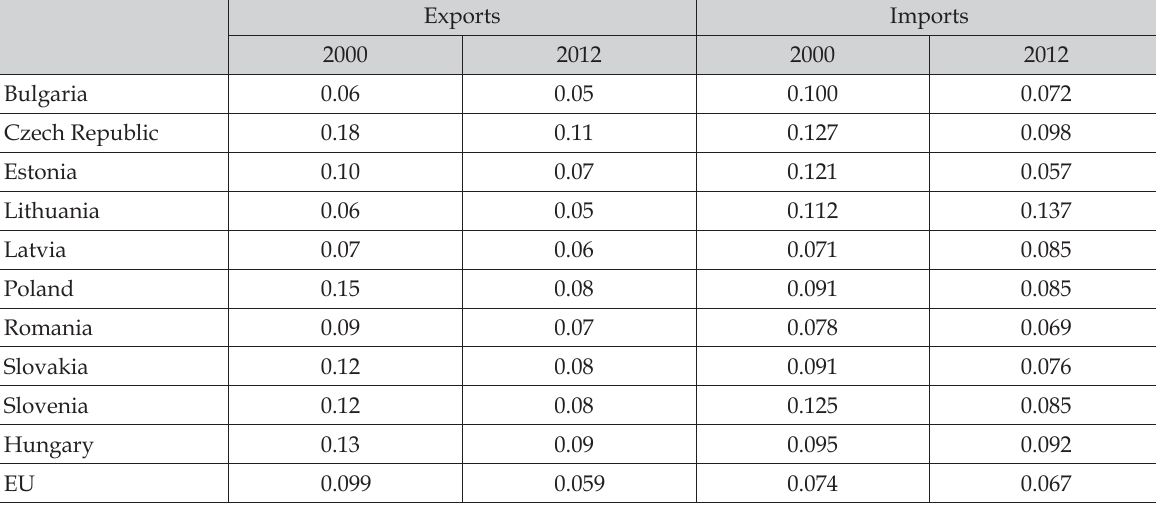
Table 2. Export and import concentration indices for the post-communist countries and the EU, 2000 and